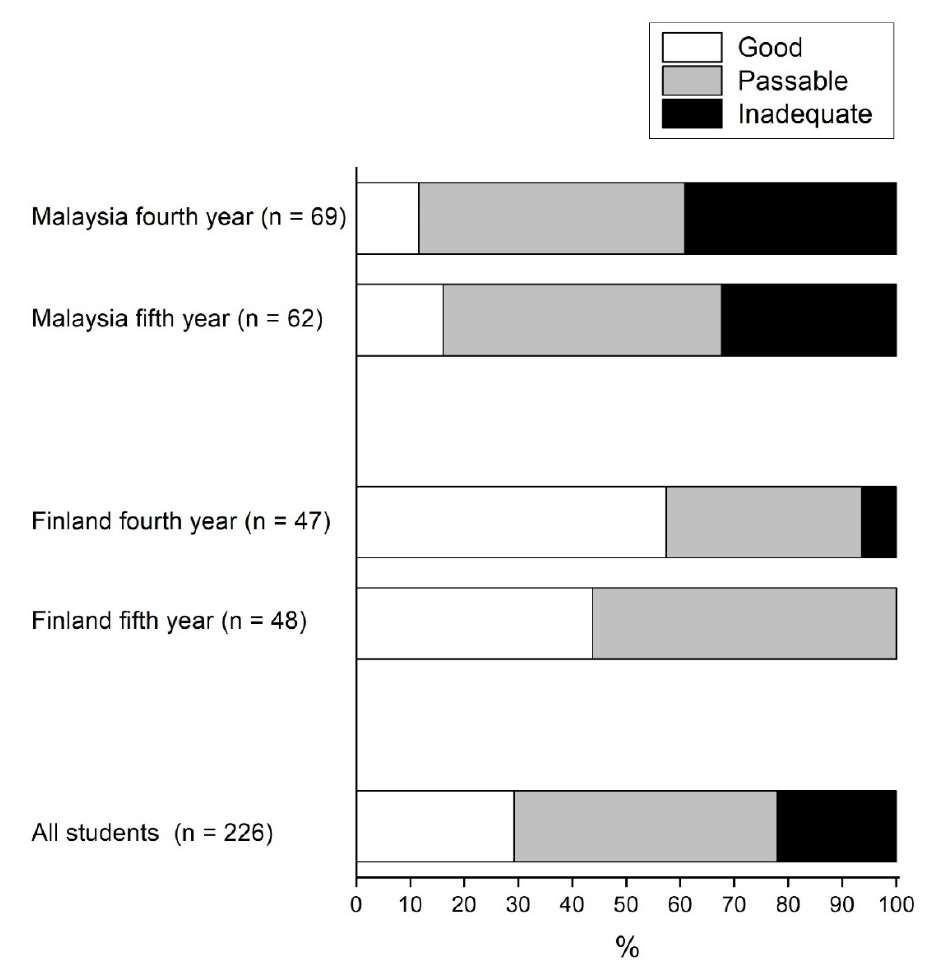
Figure 1. The percentage distributions of dental students’ perceived skills in information retrieval by dental school and year of study.